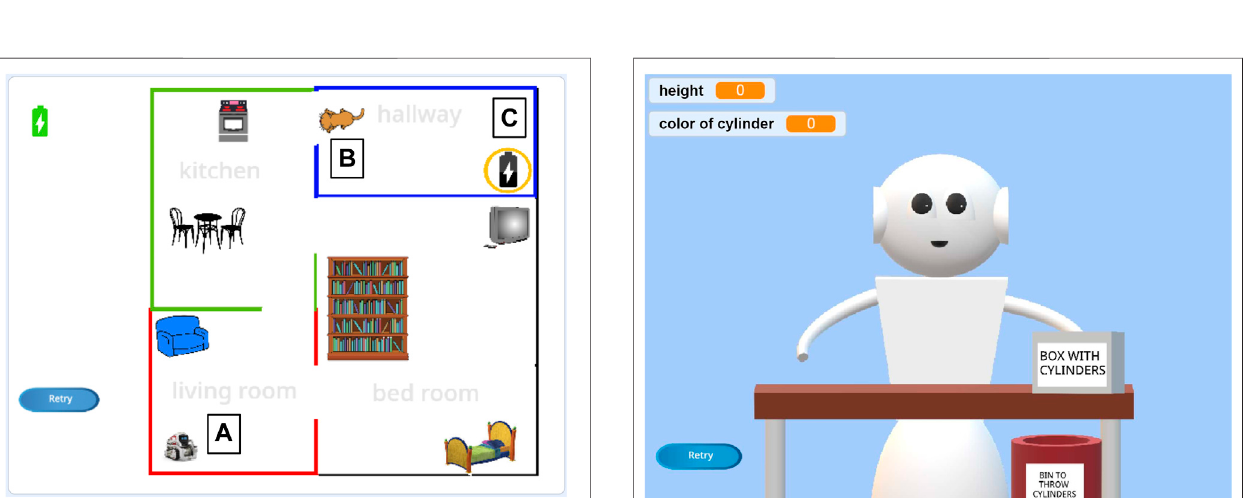
FIGURE 1 | The interface consists of (A) blocks to drag and drop to the (B) workspace. The (D) instructions explain the task. The program can be (E) run and stopped, and the program ’ s output is visualized in the (C) stage. Finally, users can (F) download their program.